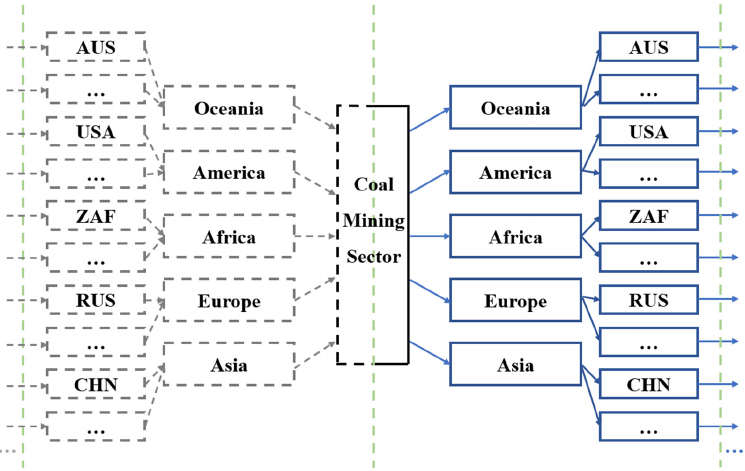
Figure 1. Carbon accounting framework for the coal mining sector.